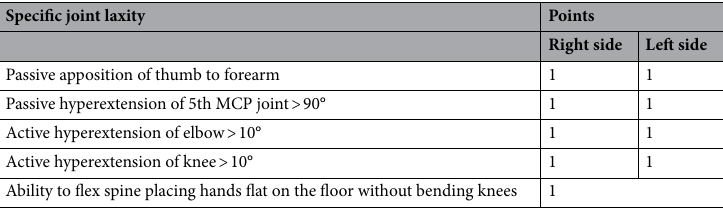
Table 5. The 9-point Beighton score of hypermobility. MCP